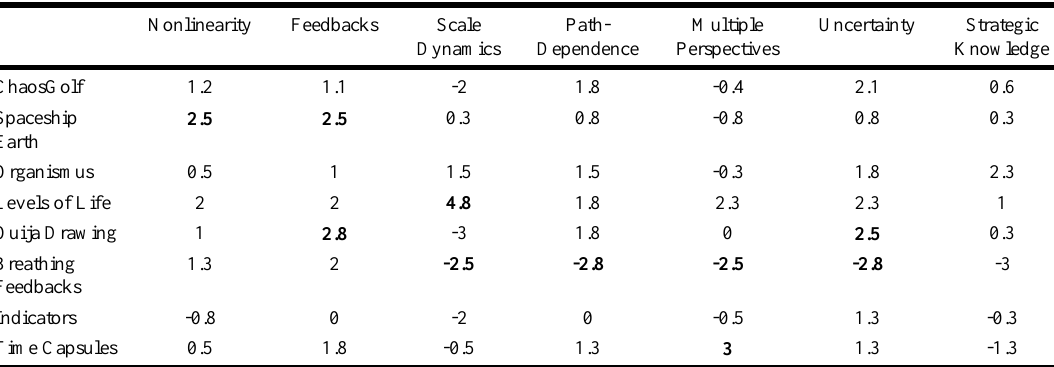
Table 2. Evaluation of concepts using complexity criteria by the science panel. Each number represents a rating between -5 and +5, with -5 standing for “extremely bad” and +5 for “extremely good.” Those in bold highlight values that are in the highest quadrant (+2.5 or higher) or in the lowest quadrant (-2.5 or